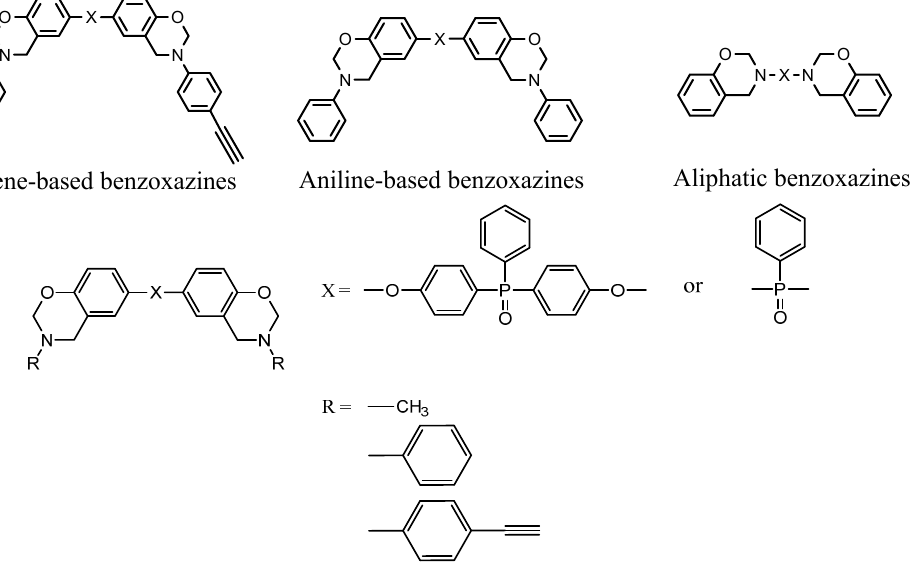
Figure 1. The general structure of some of benzoxazines in the training set.